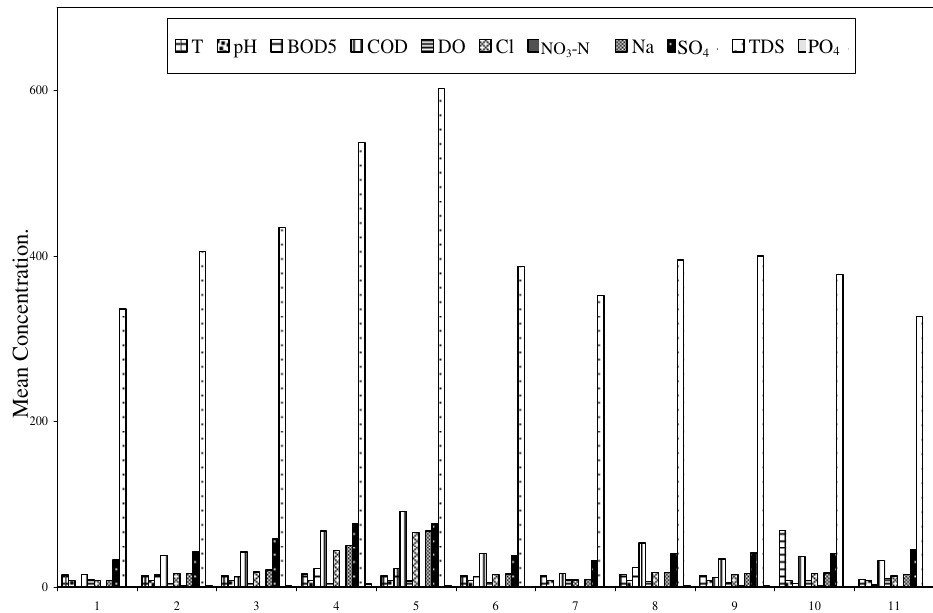
Figure 3. Surface water quality parameters mean concentrations at river observation